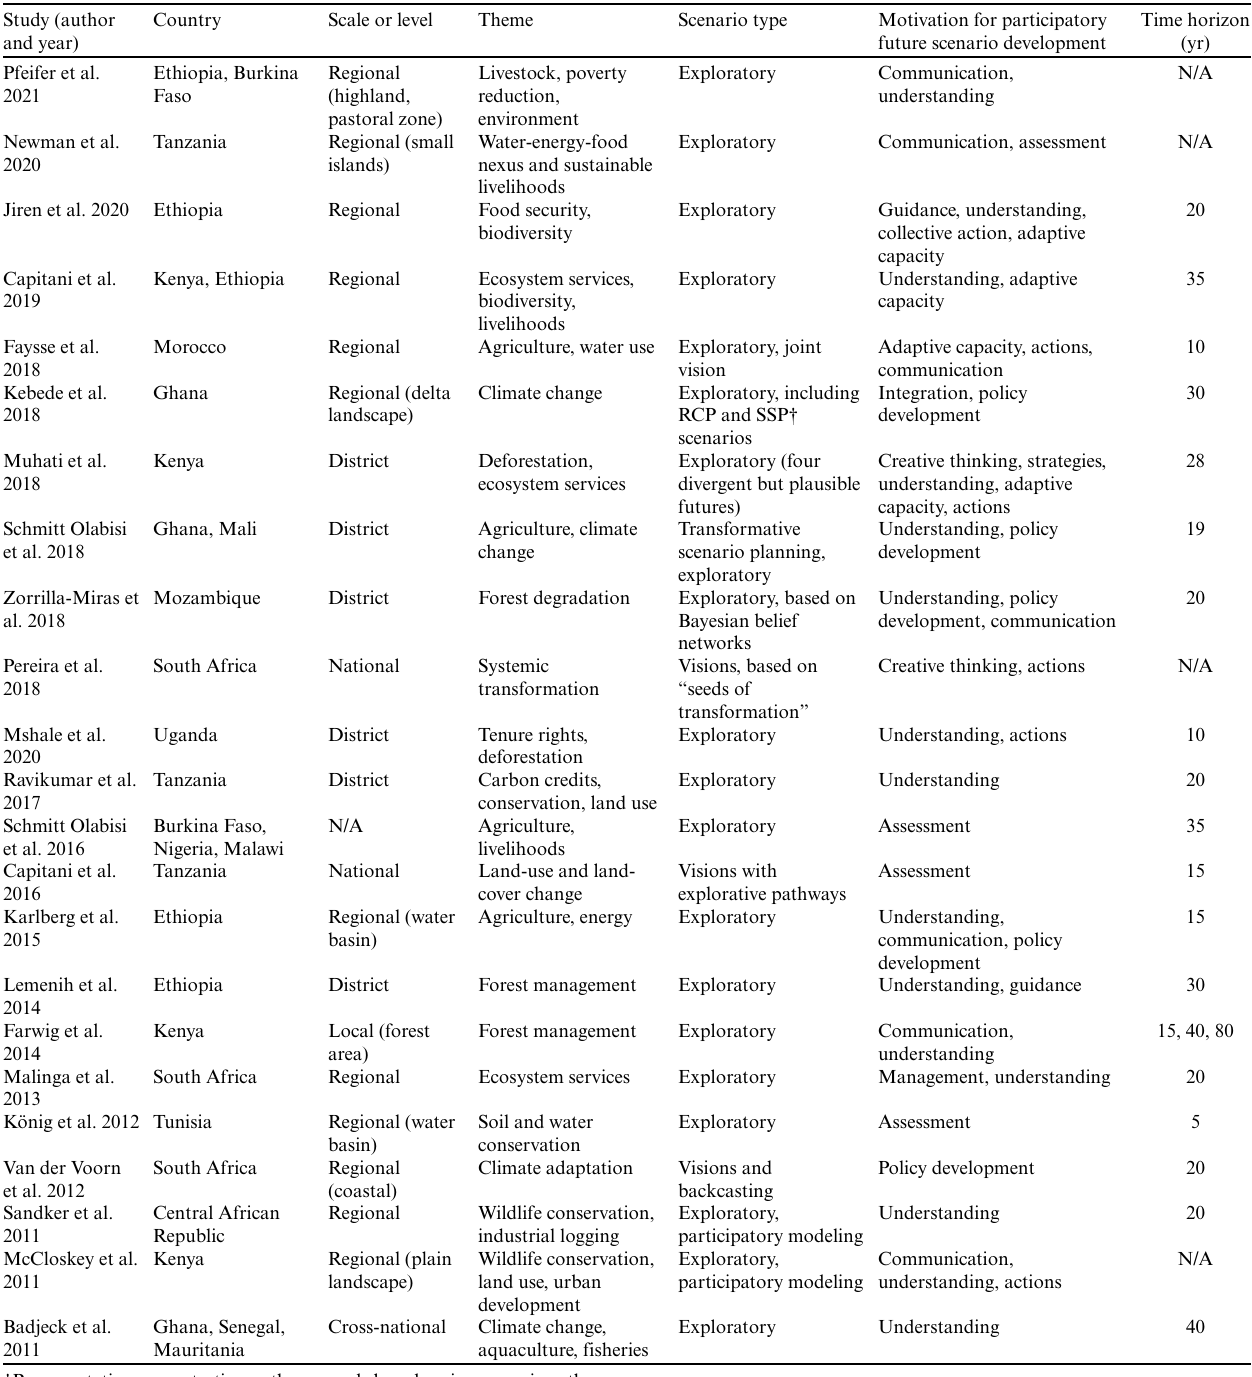
Table 3. Overview of scenario features in terms of location, scale, theme, scenario type, motivation, and time